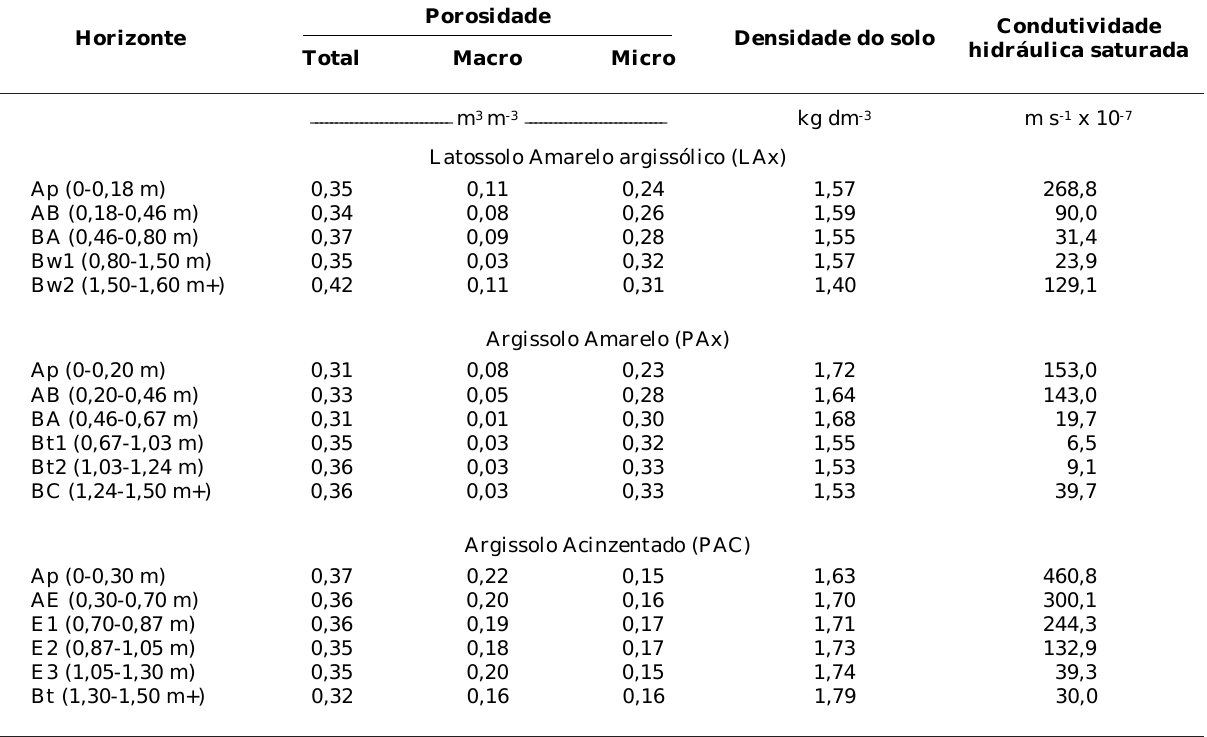
Quadro 2. Resultados de análises físicas de uma toposseqüência em tabuleiro, localizada em